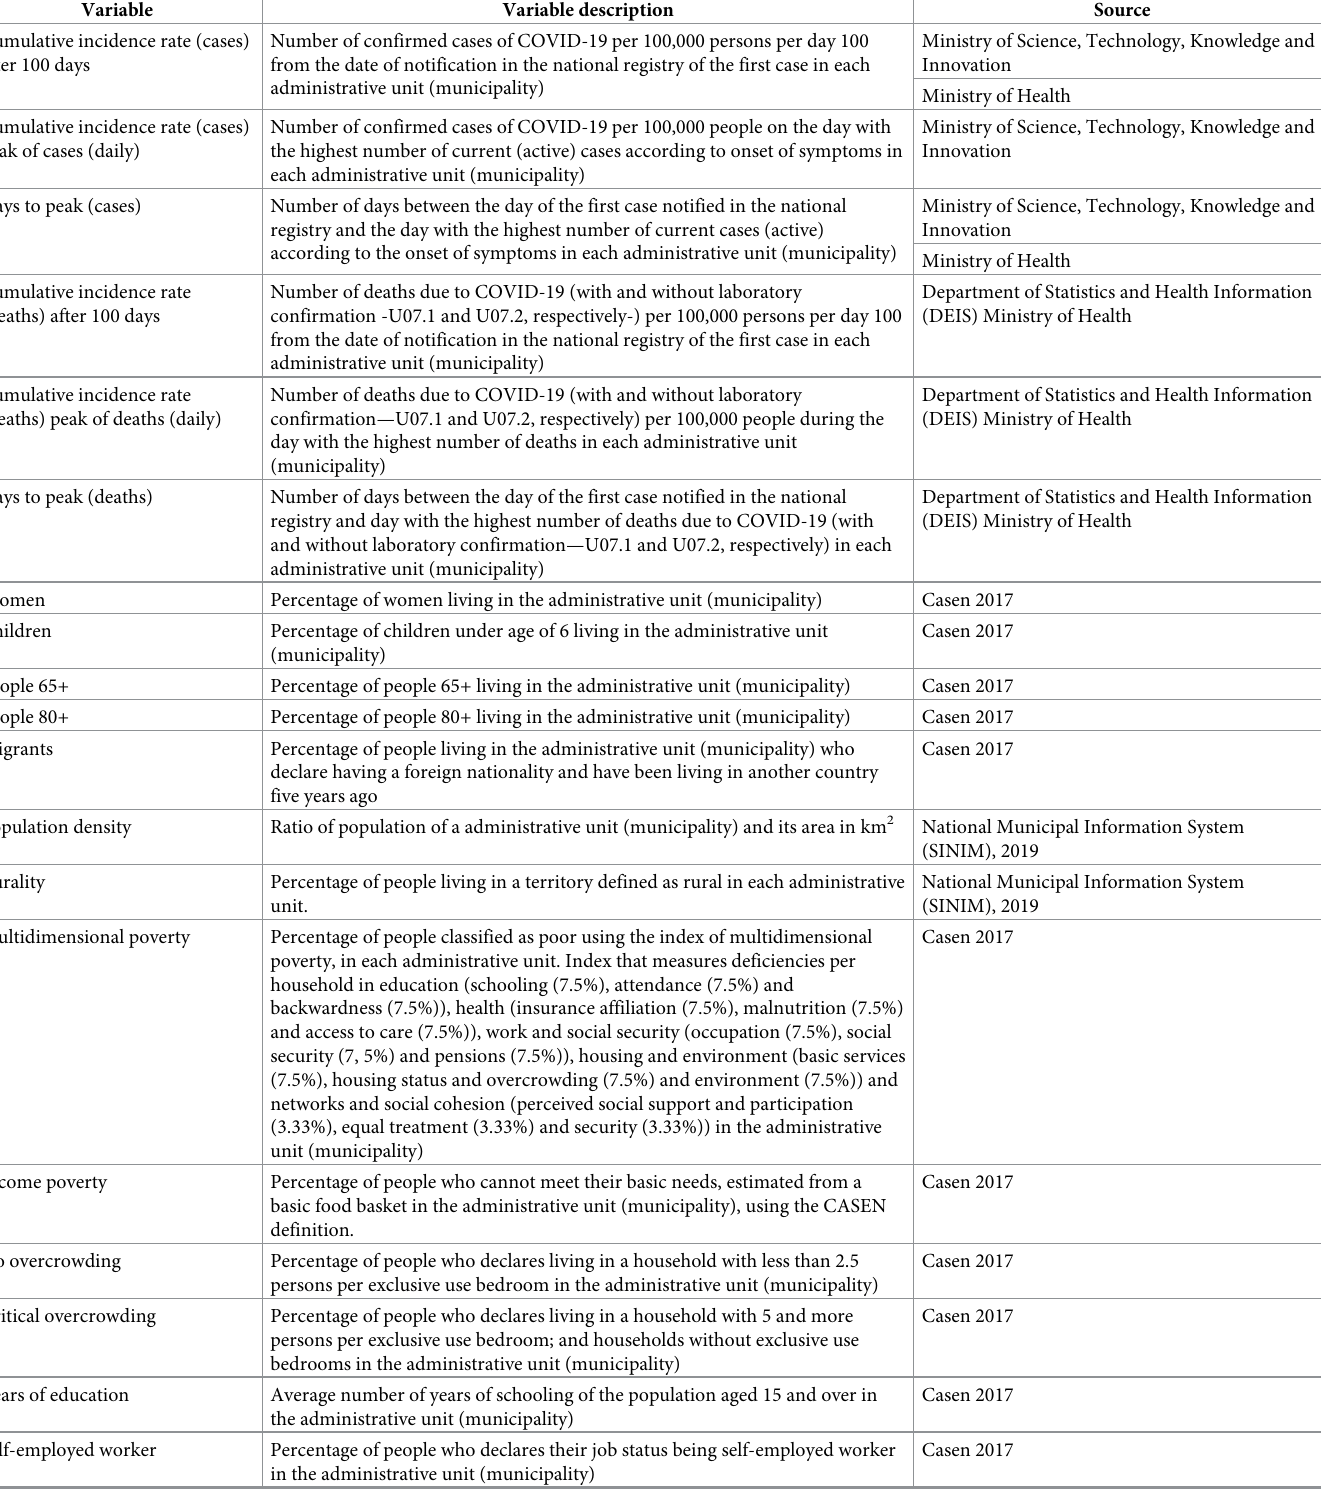
Table 2. List of variables, definitions and